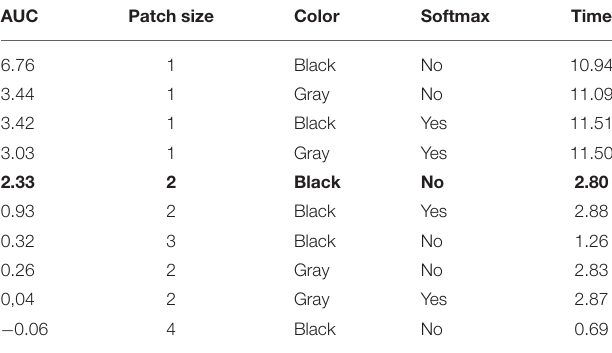
TABLE 2 | Best parameters for Occlusion Sensitivity.